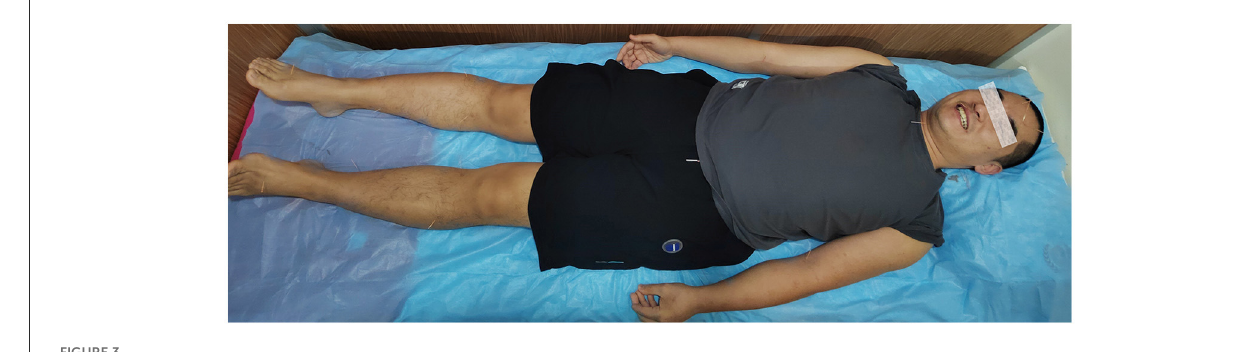
FIGURE3 The selected acupoints.